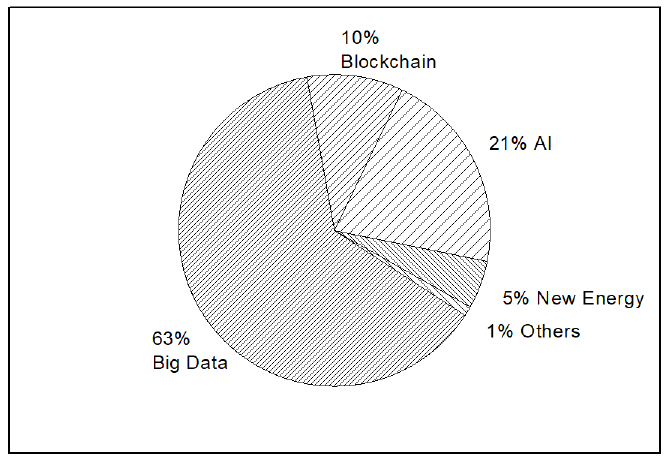
Figure 11. Distribution of popular specific business